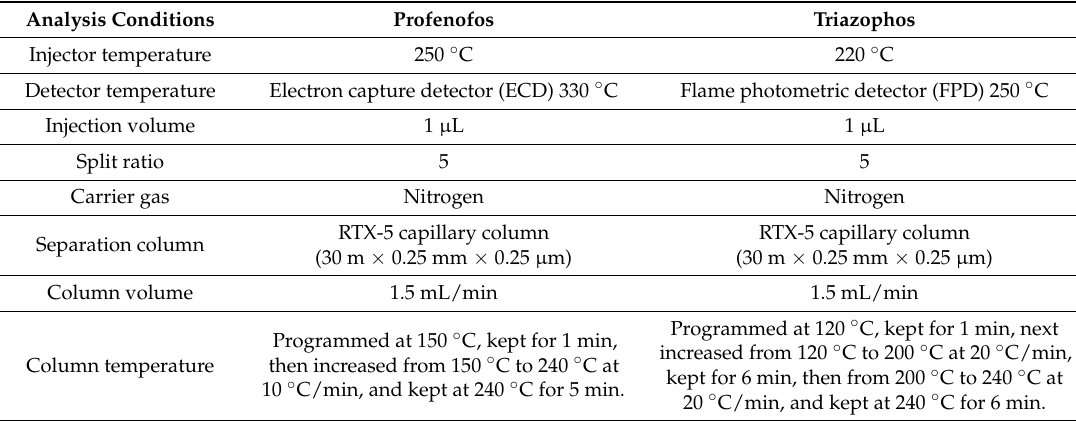
Table 3. Gas chromatography analysis